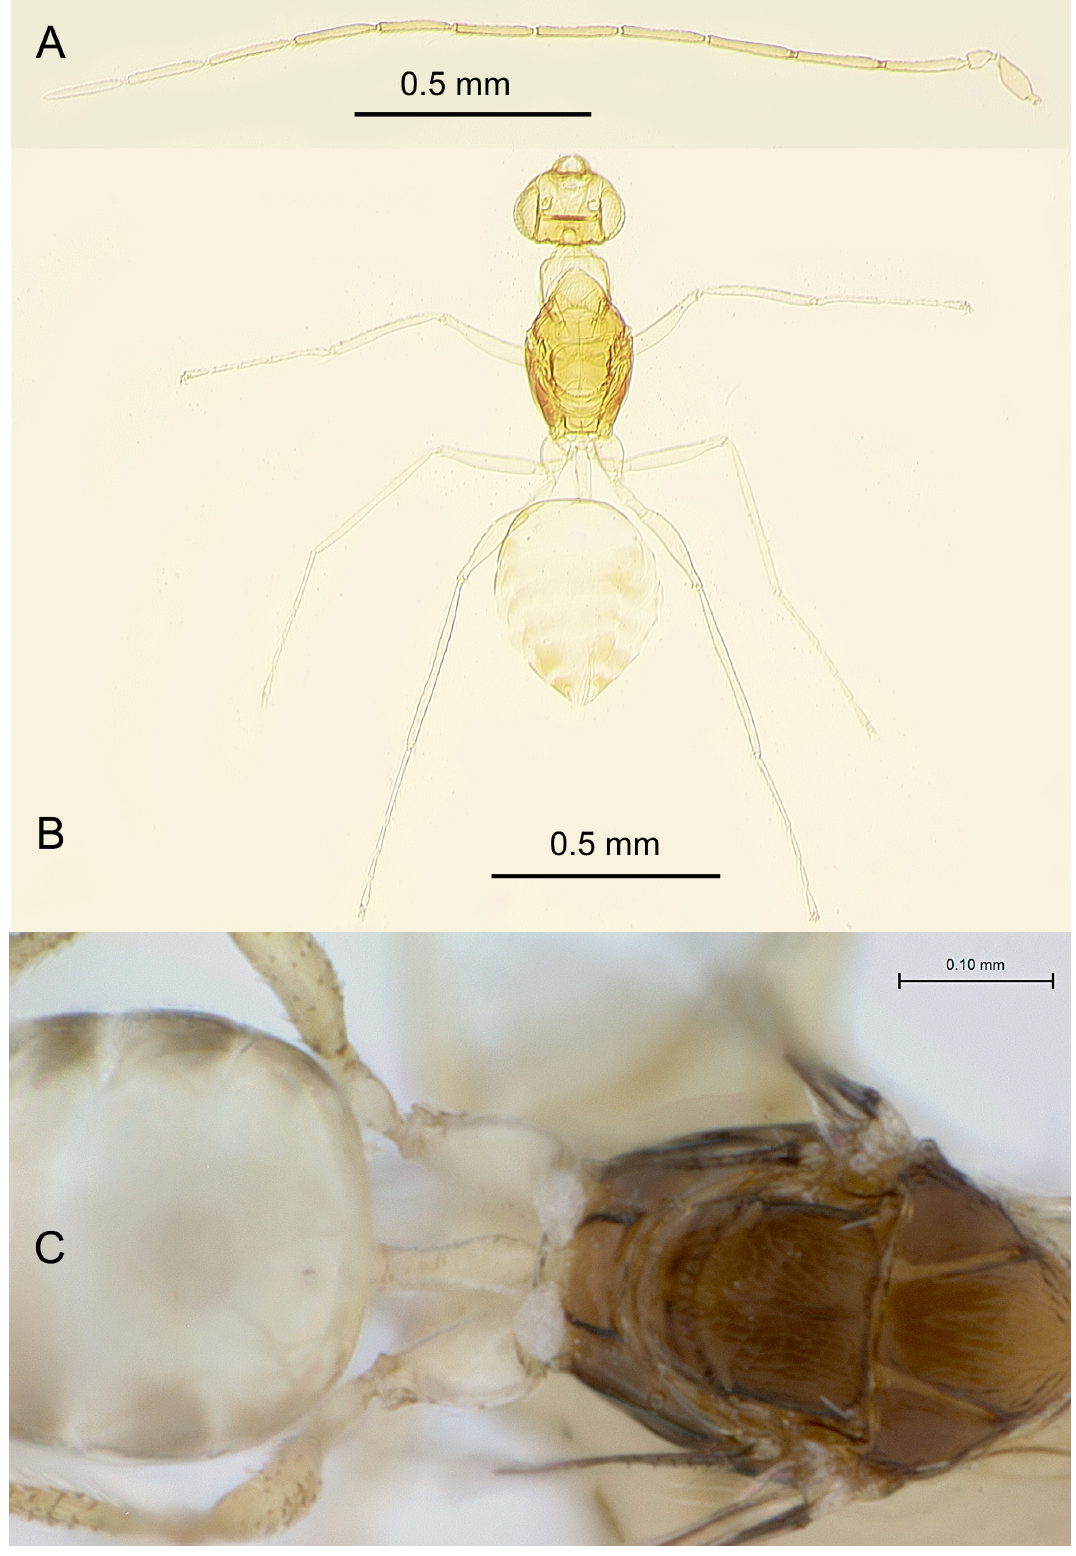
Fig. 11. Ganomymar libertatium sp. nov., ♂, paratype (CAS). A . Antenna. B . Body and legs. C . Mesosoma, petiole and base of gaster in dorsal view (prior to